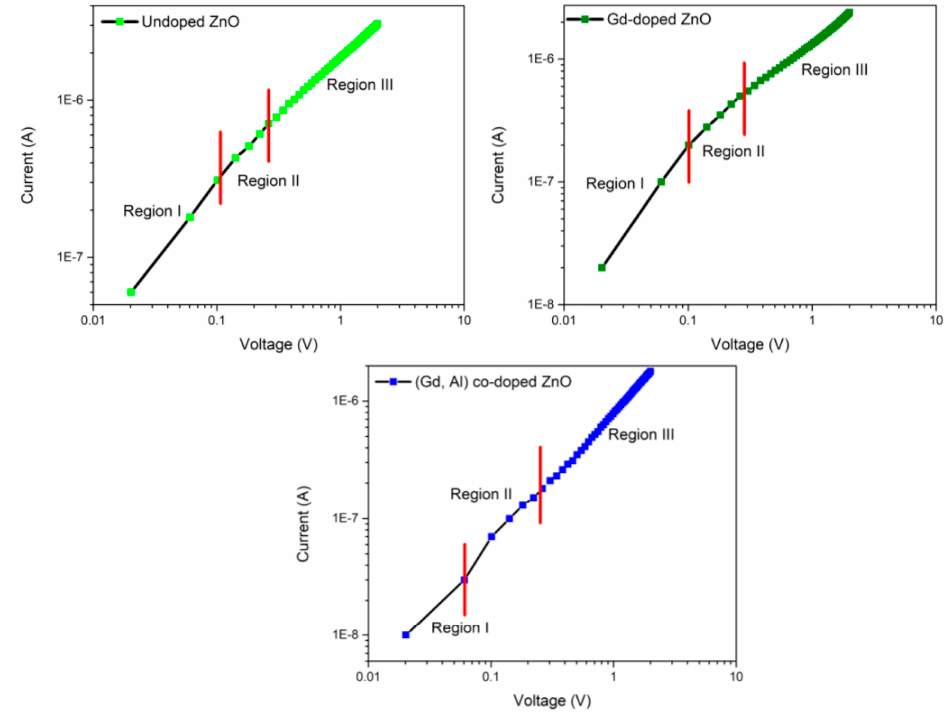
Figure 9. Double logarithmic of I-V measurements for the n-ZnO-based DMS/p-Si heterojunction.